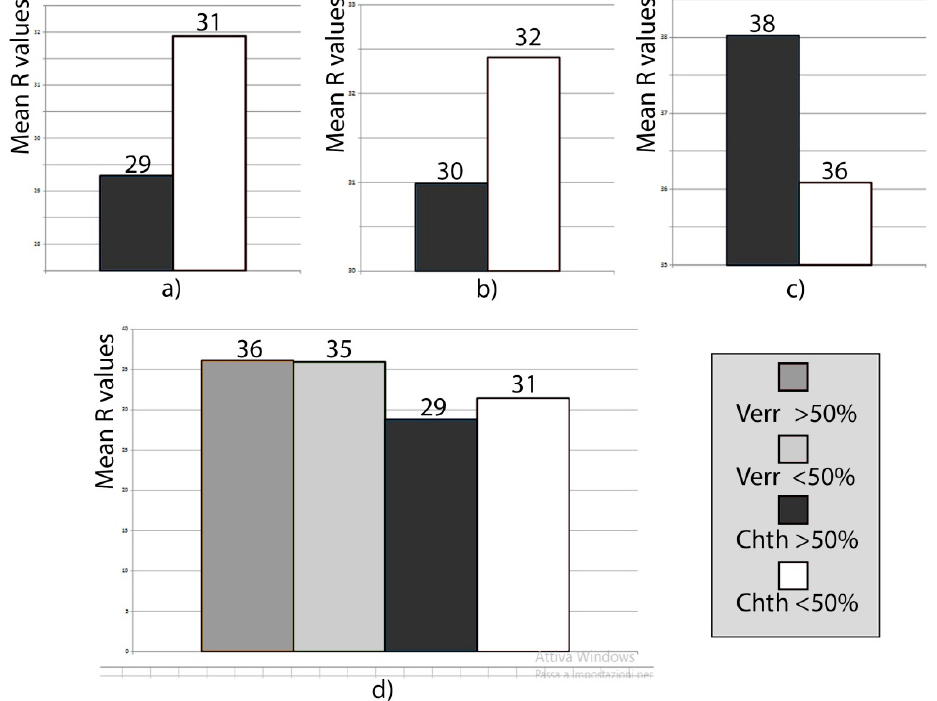
Figure 8. First order platform Chthamalus spp. coverage, Pontetto locality.